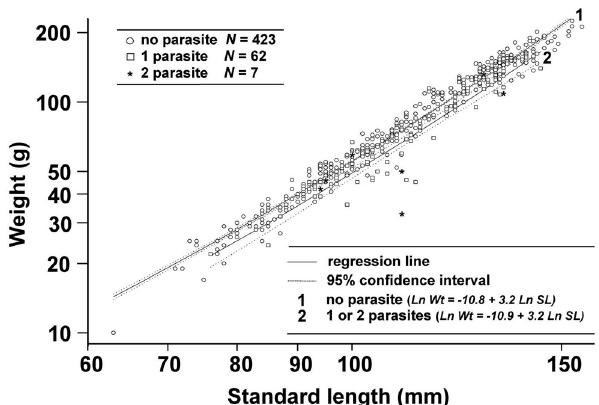
Fig. 7. Length vs . weight plots for Symphysodon haraldi specimens parasitized with the isopod gill parasite Braga cichlae , and unparasitized specimens. All specimens are from a single colony of discus in Uxi Bay, lago Amanã. Fig. 8. Length vs . weight plots for male and female Symphy- sodon haraldi from a single colony in Uxi Bay, lago Amanã.